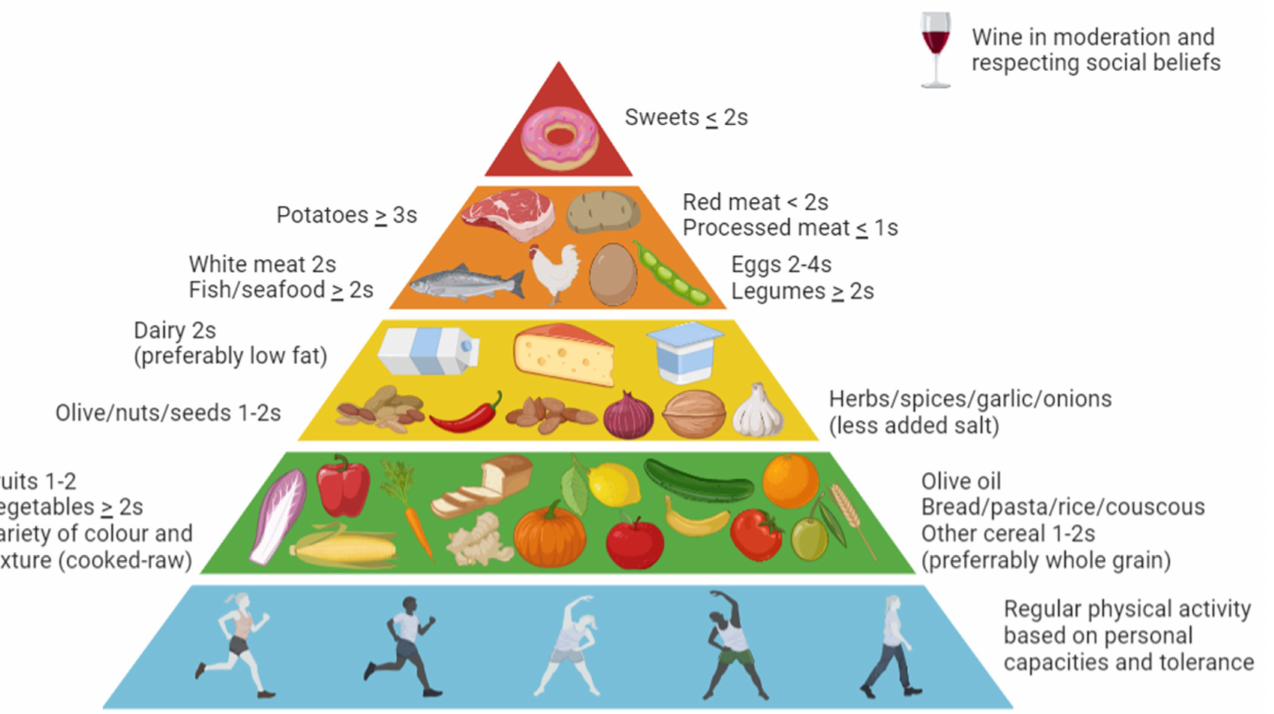
Figure 1. Med Diet pyramid: updated indications and guidelines for adult population. Note: s: servings; Adapted from “Med Diet as the diet of choice for patients with chronic kidney disease”